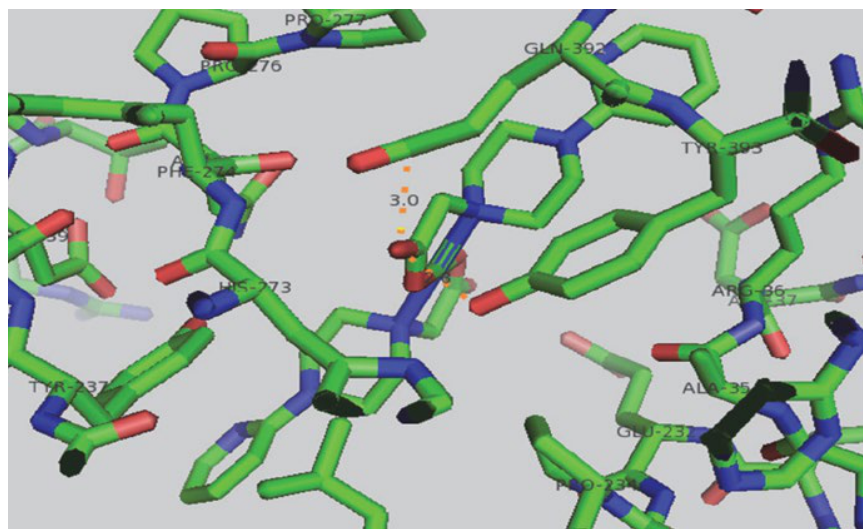
Figure 4. Binding mode of complex 1 with human monoamineoxidase -B. The complex molecule and MAO-B were shown as stick, the hydrogen bonds were shown as yellow dash